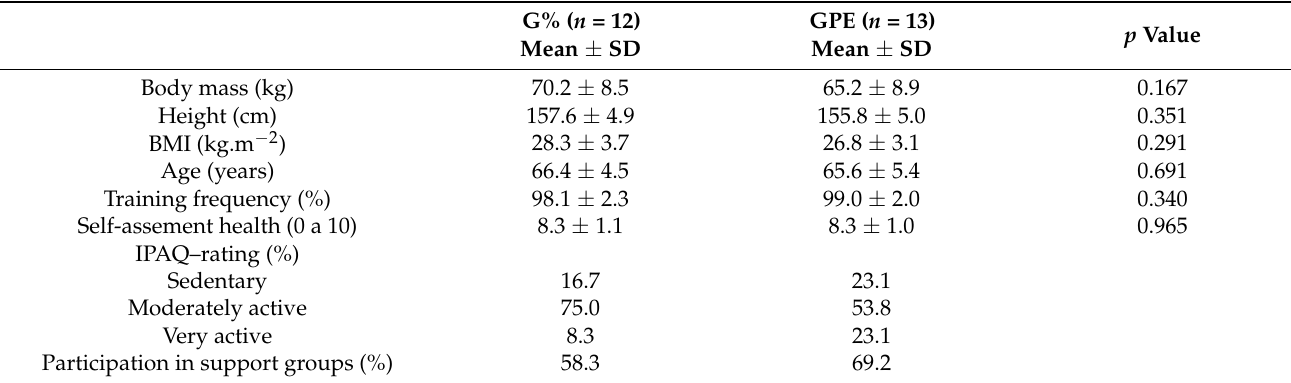
Table 1. Subjects’ demographics (mean ± standard deviation—SD).